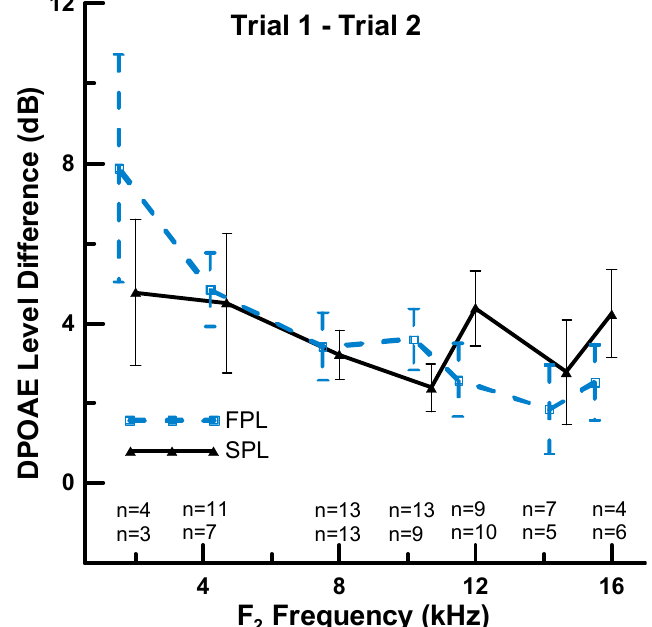
Figure 3. Average absolute DPOAE level difference between trials 1 and 2 across frequency for newborns that had present DPOAEs for each trial. DPOAEs collected with FPL calibration are shown with open light-blue squares and a short-dashed line and those collected with SPL calibration are shown with black solid triangles and a solid line. The number of data points ( n ) for each frequency are indicated, where the top value is for FPL and the bottom value is for SPL. Standard errors are shown.